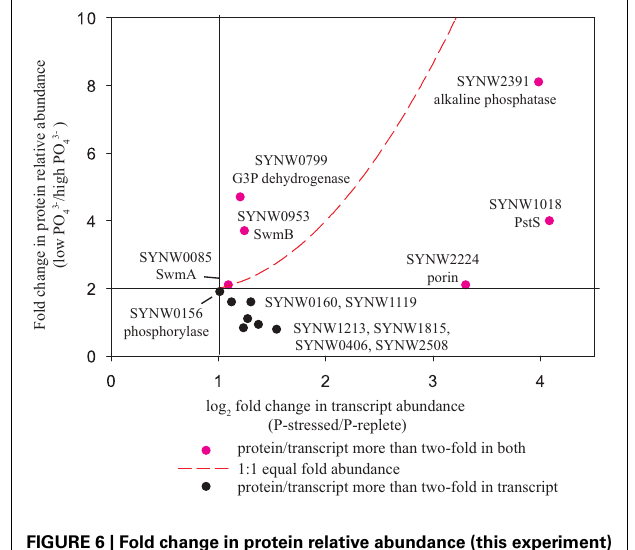
FIGURE 6 | Fold change in protein relative abundance (this experiment) as ratio of low phosphate to high phosphate vs. log 2 fold change in gene relative abundance (Tetu et al., 2009) as ratio of P-stressed to P-replete. Pink dots represent proteins/transcripts more than two-fold abundant in both protein and transcript data. Black dots represent proteins/transcripts more than two-fold abundant in transcript data. Red dashed line indicates a 1:1 equal fold abundance. SYNW0160 conserved hypothetical protein; SYNW1119 6-phosphogluconate dehydrogenase; SYNW1213 thioredoxin peroxidase; SYNW1815 ABC transporter, substrate binding protein, phosphate; SYNW0406 hypothetical protein; SYNW2508 molecular chaperone DnaK2, heat shock protein hsp 70-2. See Tables 1 , 2 .